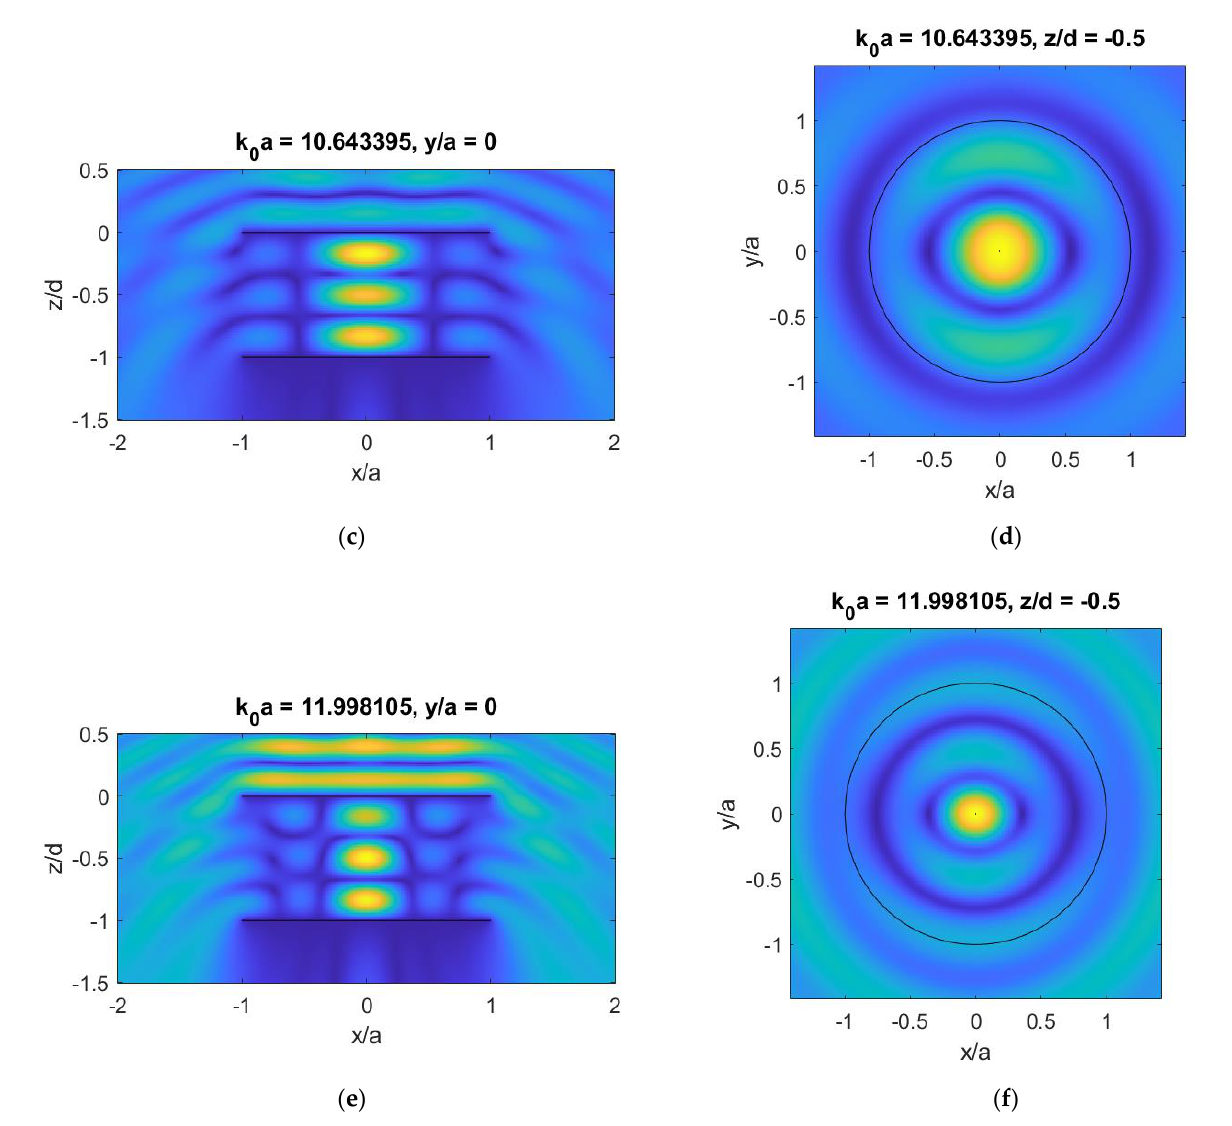
Figure 7. Near E-field behavior in the Cartesian coordinate planes xz and xy of a two stacked thin resistive disks resonator at three resonance frequencies ( k 0 a = 9.662491,10.643395,11.998105), when a plane wave orthogonally impinges onto the structure with E 0 = E 0 ˆ y : ( a ) Near E-field in the xz plane, k 0 a = 9.662491; ( b ) Near E-field in the xy plane, k 0 a = 9.662491; ( c ) Near E-field in the xz plane, k 0 a = 10.643395; ( d ) Near E-field in the xy plane, k 0 a = 10.643395; ( e ) Near E-field in the xz plane, k 0 a = 11.998105; ( f ) Near E-field in the xy plane, k 0 a =